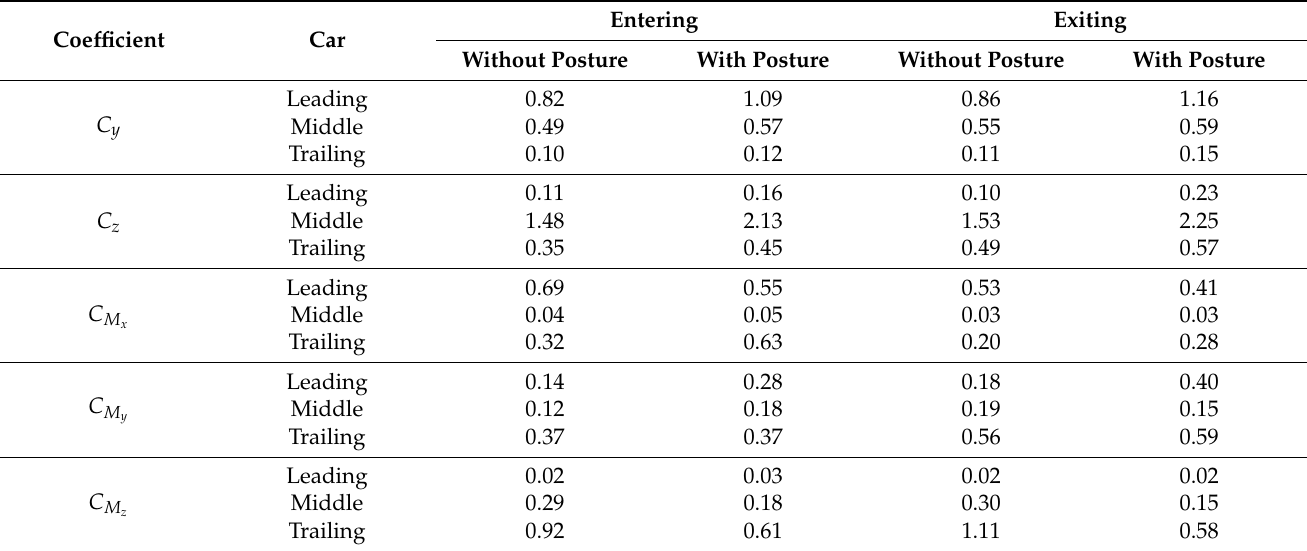
Table 2. Peak-to-peak values of the aerodynamic coefficients when each car entered and left the crosswind region with and without the